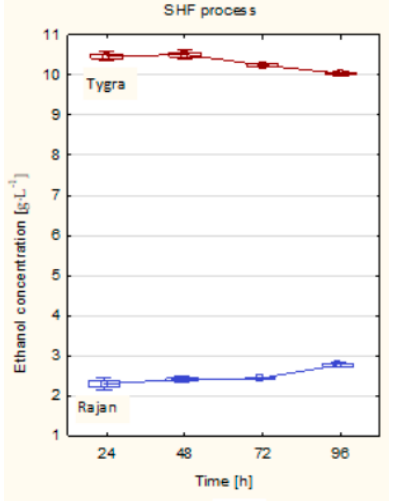
Figure 4. The ethanol concentration of hemp biomass in the SHF process. Optimized process conditions: Tygra biomass—substrate concentration 5%, enzymes: Flashzyme Plus 200 30 FPU ∙ g − 1 of solid, glucosidase 20 CBU ∙ g ‐ 1 of solid and xylanase 500 XU ∙ g − 1 of solid, temperature 50 °C, pH 4.2, and time 48 h. Rajan biomass—substrate concentration 5%, Flashzyme Plus 200:Celluclast 1.5L (70:30) enzyme complex with a dose of 10 FPU ∙ g − 1 of solid, temperature 50 °C, pH 5.4, and time 72 h.